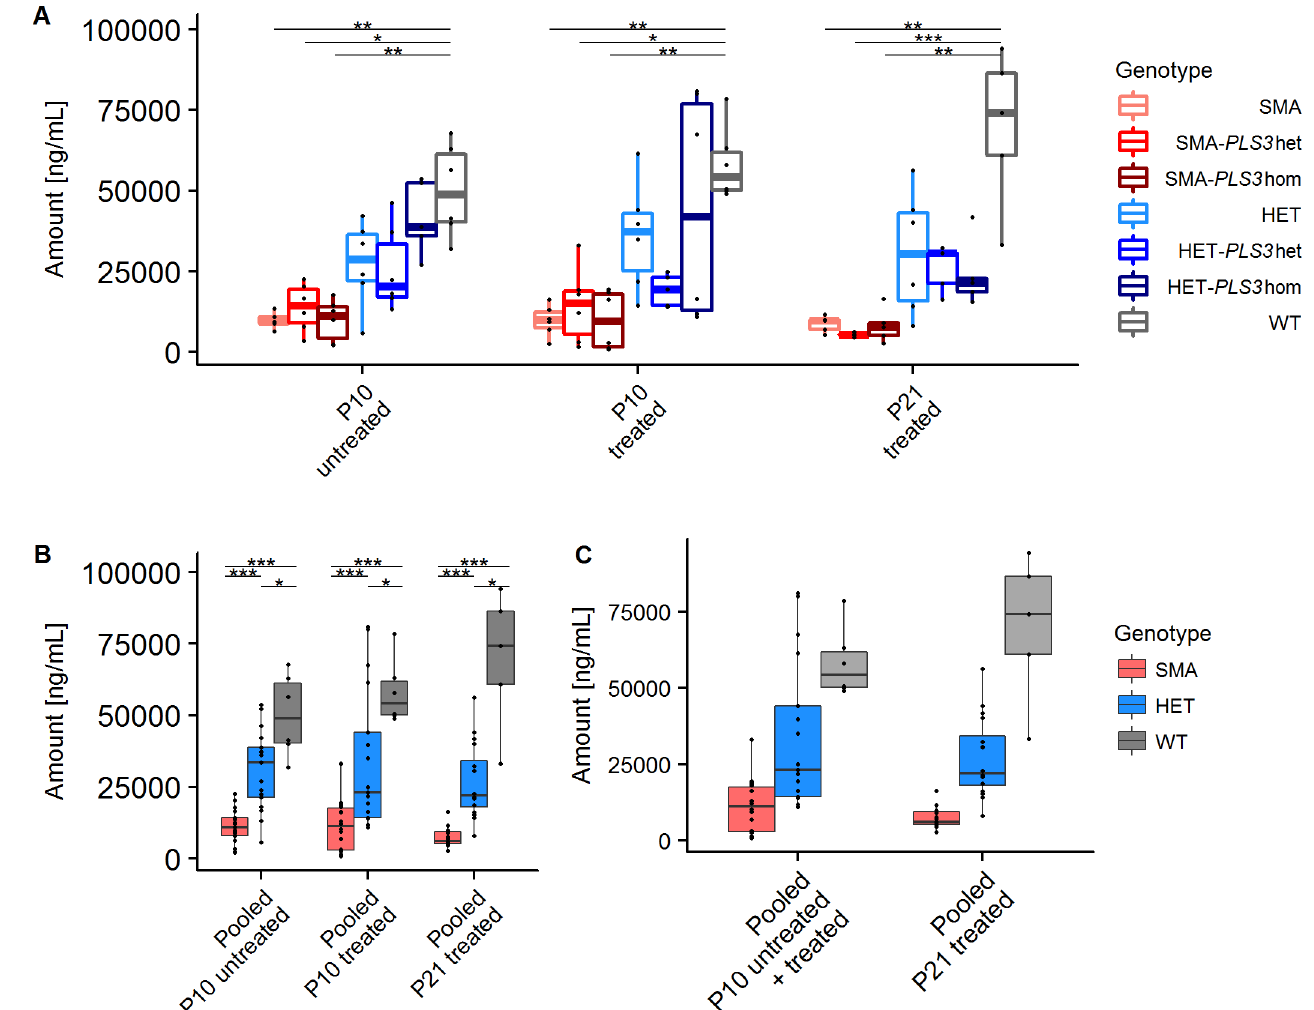
Fig 2. SMN protein concentrations in blood. (A) Multiple comparisons of SMN concentrations in untreated or ASO-treated groups with and without PLS3 overexpression at P10 and P21 in comparison to WT and WT+ASO, respectively (see also Table 1). (B) Multiple comparisons of pooled groups at P10 and P21 showing SMN concentrations in comparison to WT and WT+ASO, respectively (see also S5 Table). (C) Longitudinal comparisons of pooled ASO-treated groups at P10 and P21 showed no significant differences in the SMN concentration between the two time points (see also S10 Table). (Dunn tests, multiple comparisons, Holm corrected). Only comparisons leading to a significant difference are shown ( (cid:3) P (cid:20) 0.05; (cid:3)(cid:3) P (cid:20) 0.01, (cid:3)(cid:3)(cid:3) P (cid:20)